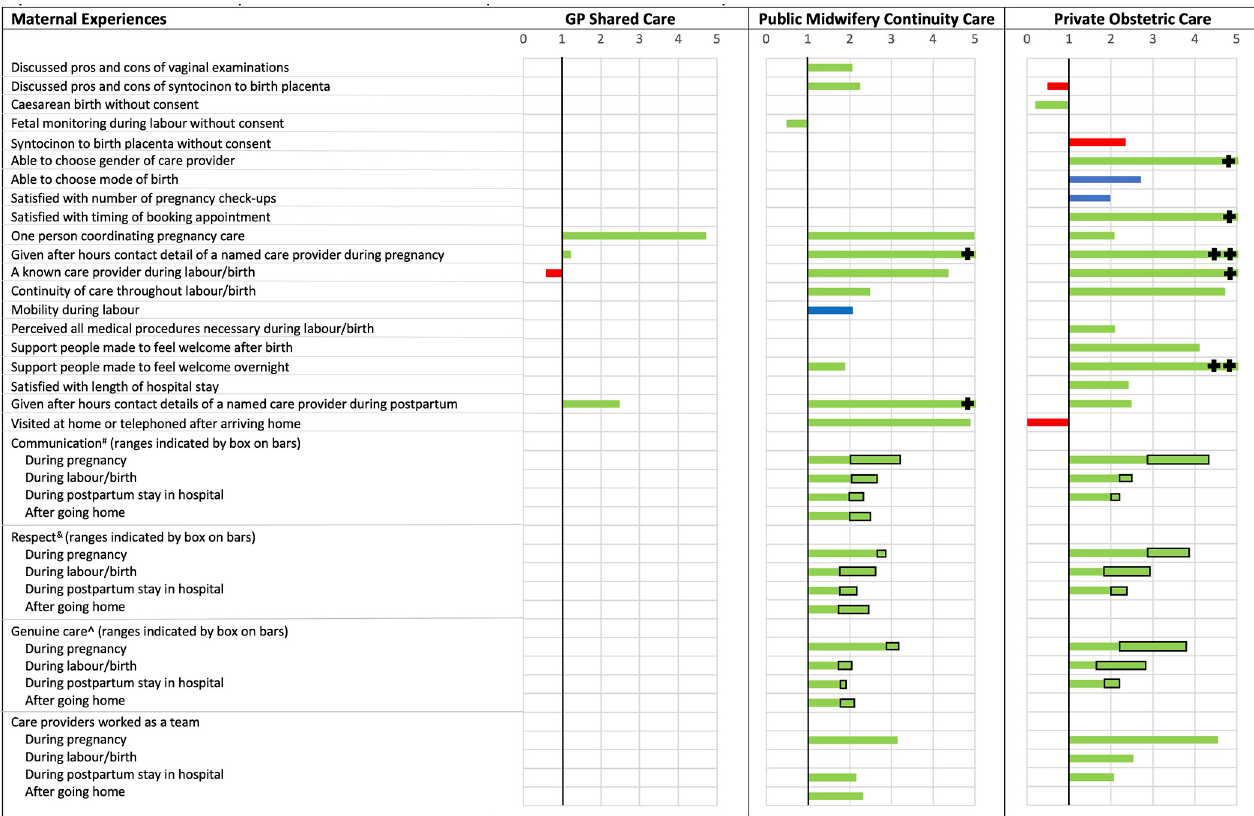
Fig 2. Adjusted odds � # of maternal experiences significantly different to Standard Public Care 1 . Green indicates more optimal experiences, red indicates less optimal experiences and blue indicates experiences with differential value dependent on consumer needs and preferences.